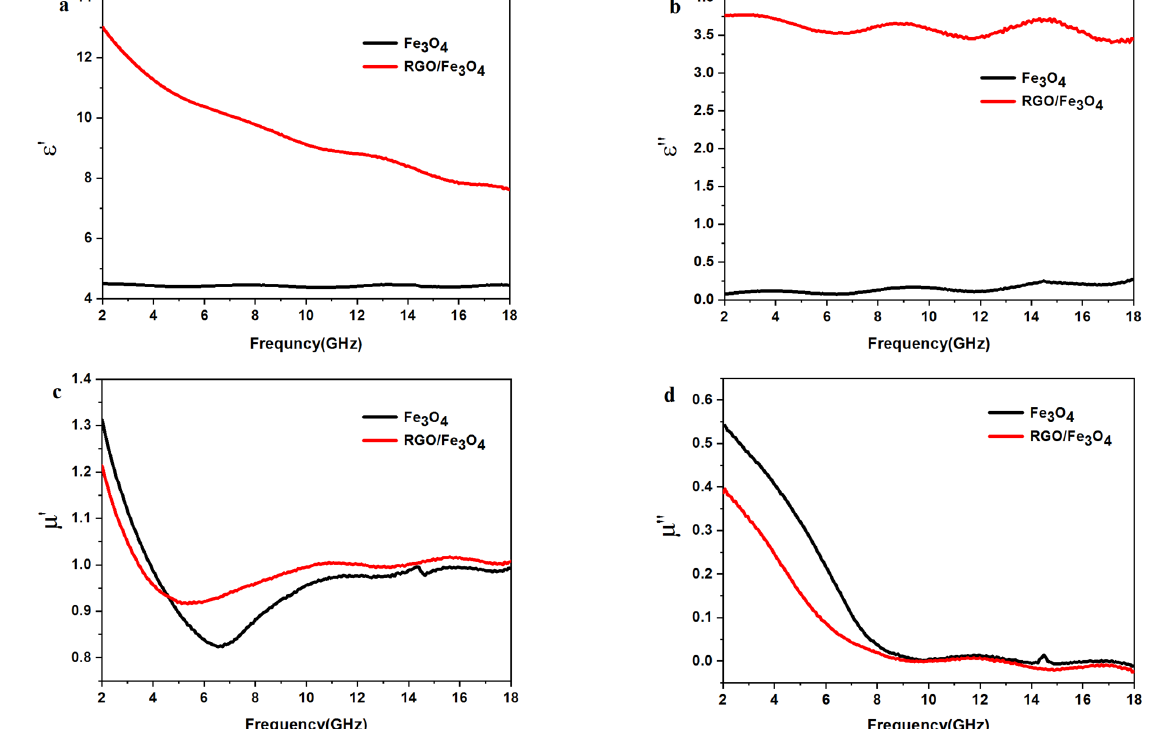
Figure 9. ( a ) The real part of permittivity ( ɛ ′ ), ( b ) imaginary part of permittivity ( ɛ ″ ), ( c ) real part of permeability ( µ ′ ), ( d ) imaginary part of permeability ( µ ″ ) of all tested samples.